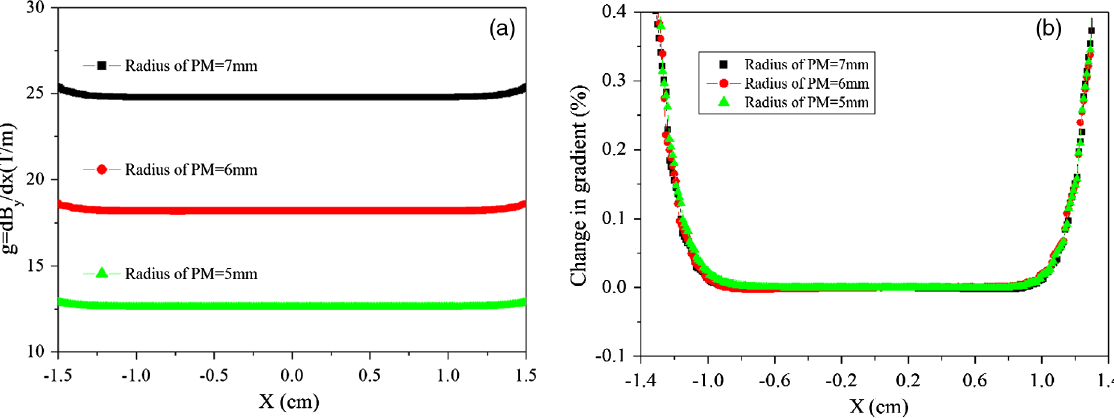
FIG. 3. Quadrupole field strength at the center of the magnet, when the radius of each PM is 5, 6, and 7 mm, respectively (a). The gradient uniformity of 0.1% is extended up to a radius of 1.2 cm, which is called the radius of good field zone